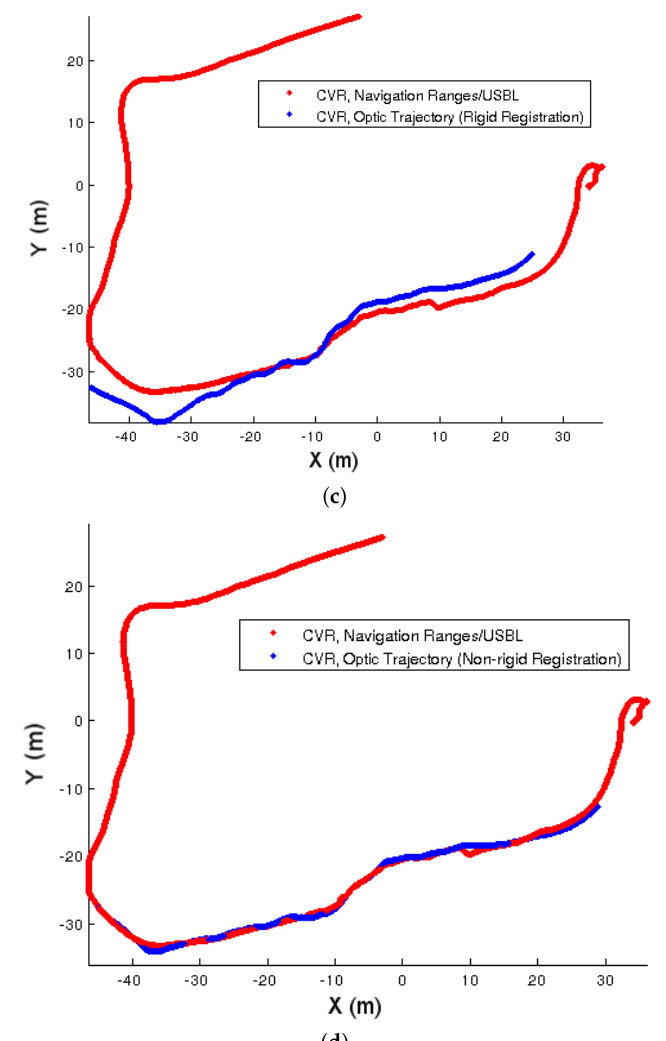
Figure 4. Sant Feliu dataset: trajectories at different steps of the optimization. The original dead reckoning trajectories of each vehicle are shown in ( a ). Then, the navigation trajectories after being optimized using USBL and range measurements are illustrated in ( b ). Finally, the two steps of the optical trajectory optimization are shown in ( c )—rigid registration—and ( d )—final non-rigid registration.